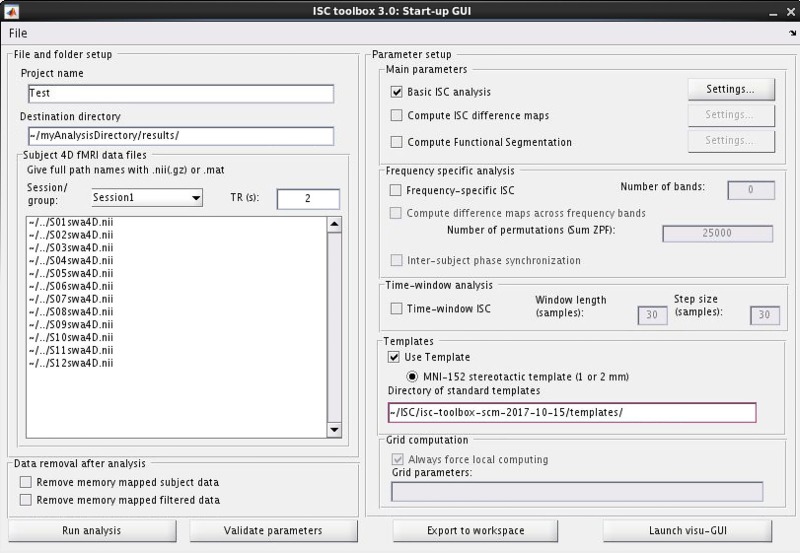
Screenshot from the GUI of the ISC Toolbox. File names are abbreviated here for illustration purposes.